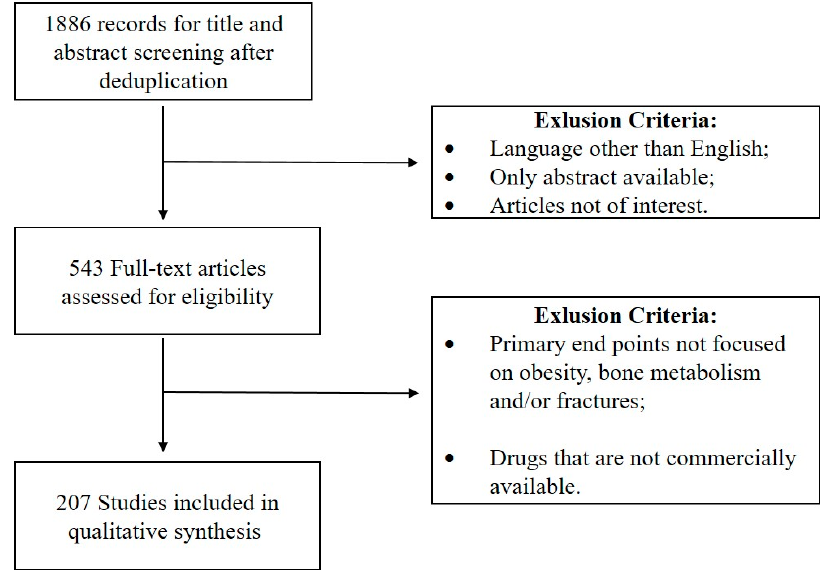
Figure 1. The process of study selection.